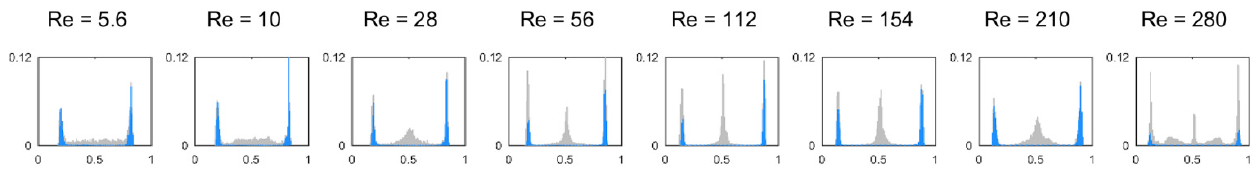
Figure 4. Spatial distributions (Probability Density Functions, PDFs) of 8.44-µm particles in the channel midplane over normalized lateral positions for various Re at a fixed distance from the channel inlet z / H = 1000 and a particle volume fraction Φ = 0.05%. Spatial distribution of all the particles identified in the acquired images are represented in grey, while the blue PDFs correspond to particles located in the midplane.